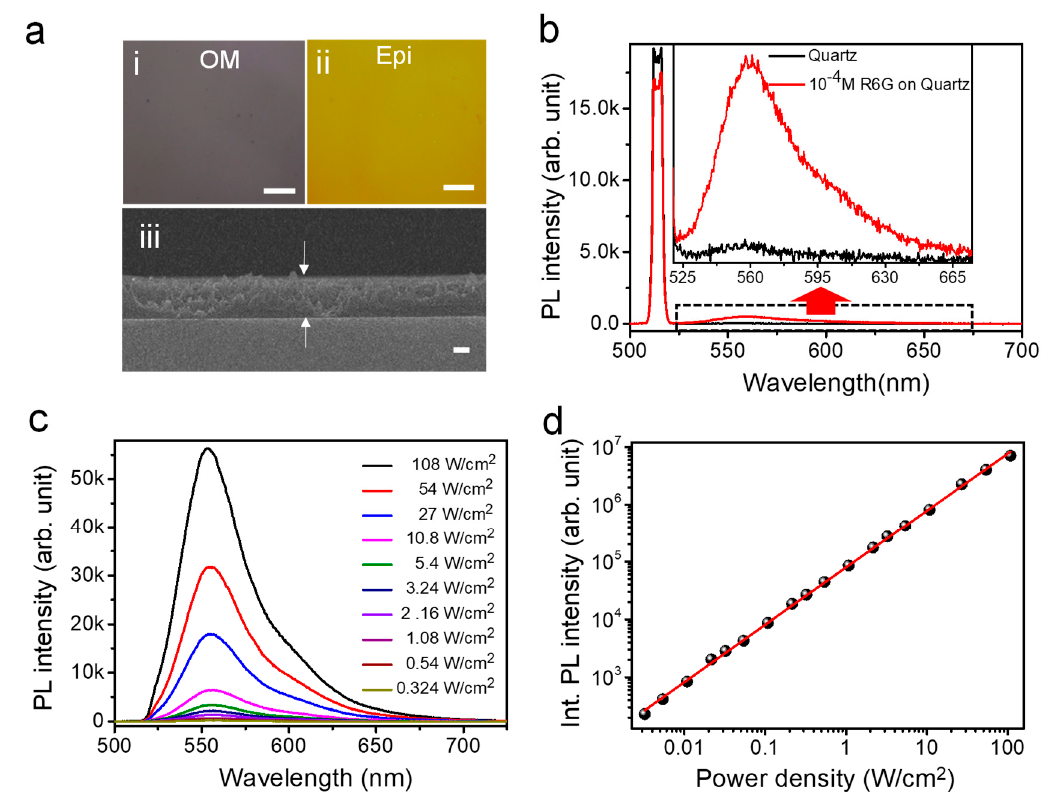
Figure 1. ( a ): (i) Optical microscopy, (ii) epi-fluorescence, and (iii) Scanning electron microscopy (SEM) (cross section showing the uniform thickness of 300 nm) images of a thin film fabricated using a poly methyl methacrylate (PMMA) C4 with 10 − 4 M of rhodamine 6G (R6G) (the scale bars in the optical and SEM images are 5 µm and 100 nm, respectively). ( b ) Photoluminescence (PL) spectrum of a 300-nm-thick film with 10 − 4 M of R6G and a bare quartz substrate measured using an integrating sphere. The inset illustrates a magnified portion of this spectrum for the emission range of R6G. ( c ) Representative confocal PL spectra of the 300 nm thick reference sample with 10 − 4 M of R6G at varied laser intensities under a 514-nm excitation. ( d ) Integrated PL intensity of a 300-nm-thick reference sample with 10 − 4 M of R6G as a function of the laser intensity.